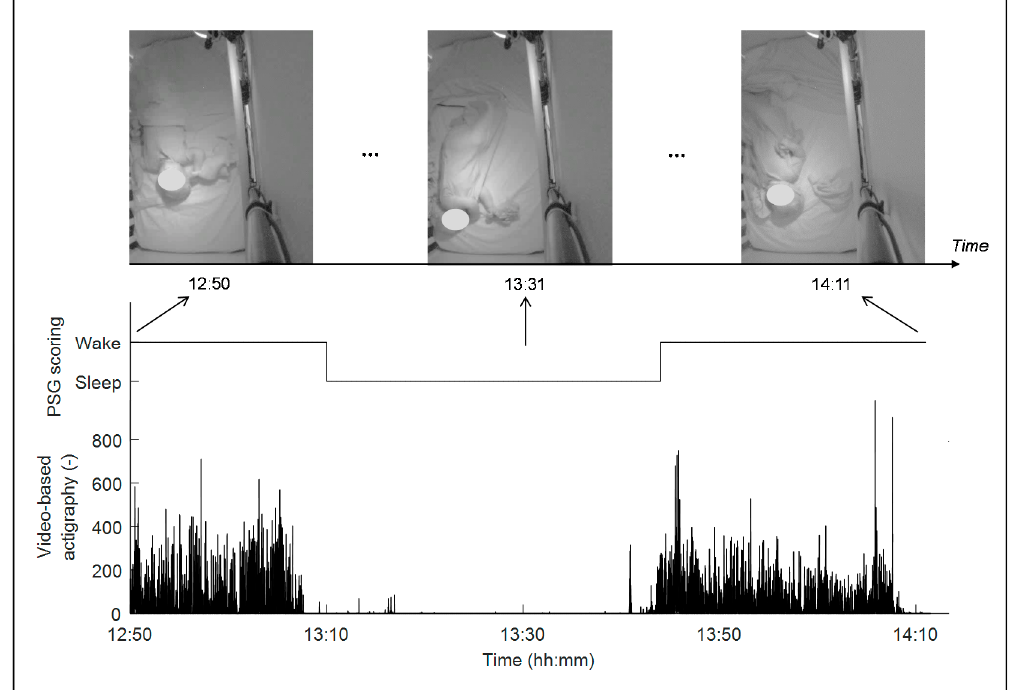
Figure 1. Example of video frames in a 1.35 h recording, and the estimated video-based actigraphy and wake/sleep state. The sampling rate of the video and the video-based actigraphy is 10 Hz. The face of the infant is blurred for privacy purposes.